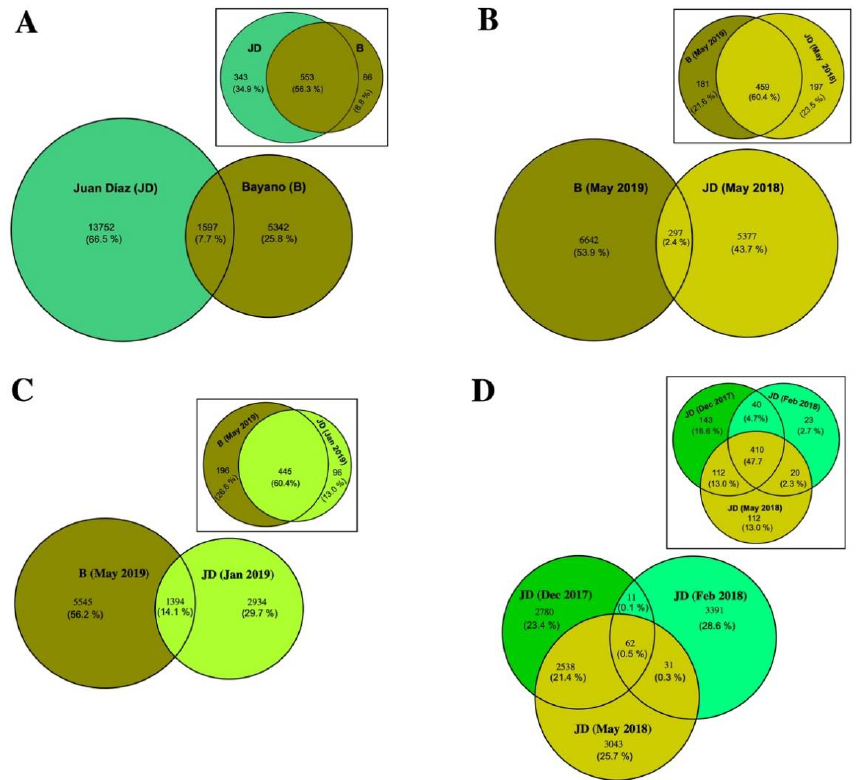
Figure 4. Venn diagram of the number (whole values) and percentage (in parenthesis) of unique and shared ASVs and genera (inner plots within squares) between sites. Comparison using the whole dataset ( A ). Comparison using data for one month (same season) in different years ( B ). Com- parison using data for one month (different seasons) in the same year ( C ). Comparison of different months in Juan Díaz ( D ).